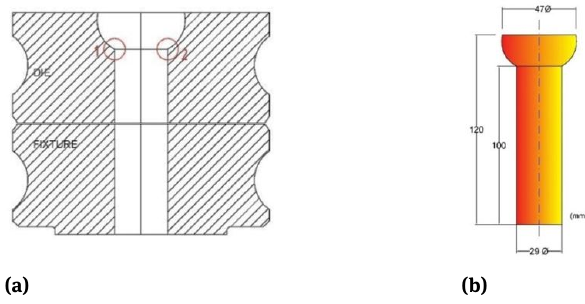
Figure 6: Shape and dimensions (a) die and fixture (b)